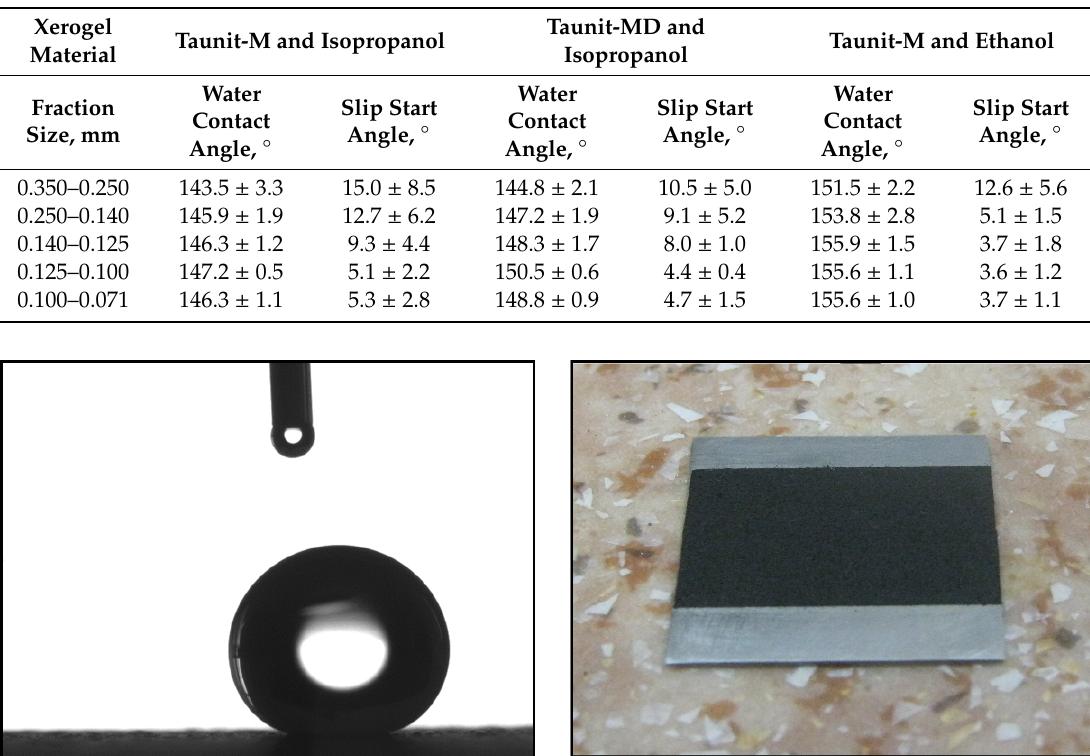
Table 3. Influence of the fraction size and the dissolvent type on the hydrophobic properties of the coating.